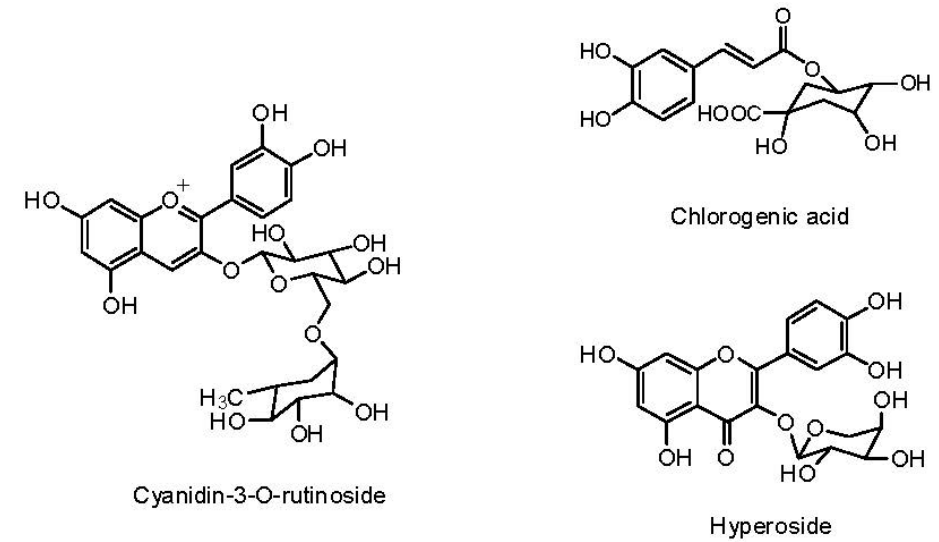
Figure 3. Chemical structures of major phenolic